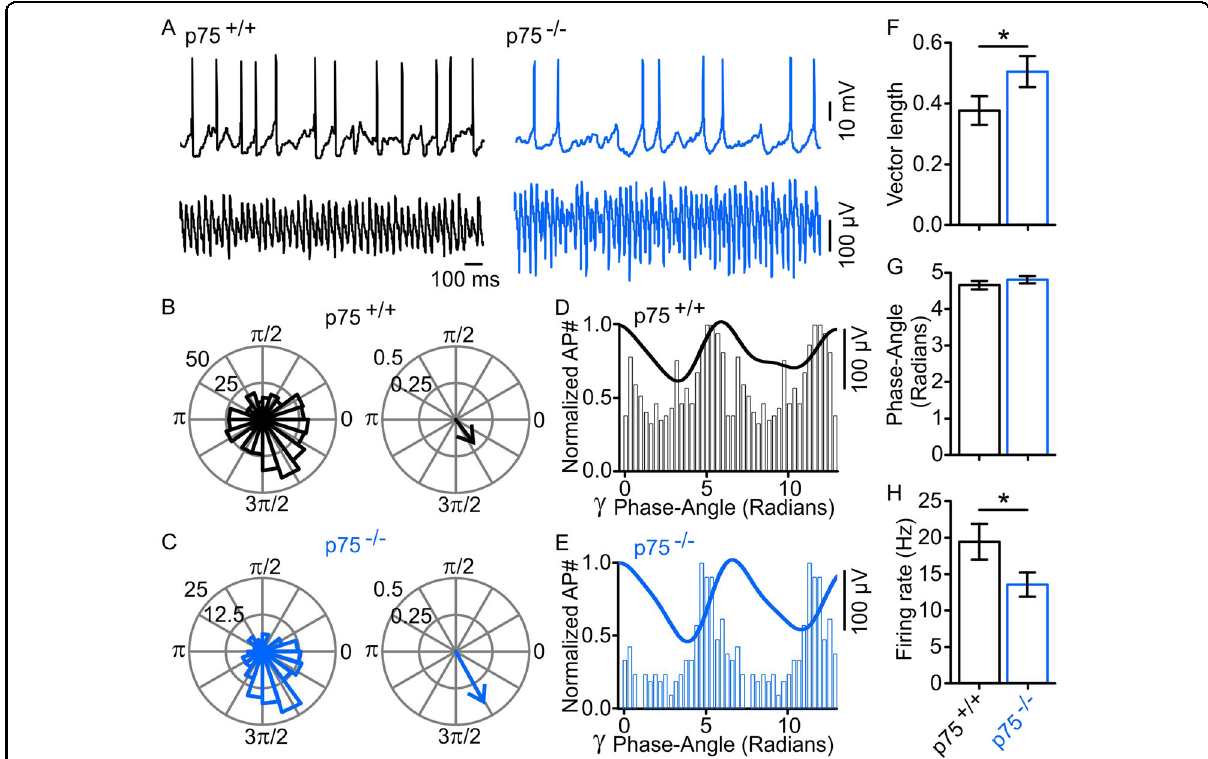
Fig. 3 AP fi ring window of fast-spiking interneurons in p75 + / + and p75 − / − mice. A Representative traces of AP fi ring from fast-spiking interneurons were recorded concomitantly with gamma oscillations ( γ ) in area CA3 20 min after 20 µM CCh. B Polar plots showing the distribution of APs within the γ cycle in p75 + / + mice. Note that a narrower fi ring distribution resulting in a larger vector in p75 − / − mice ( C ) denotes a higher fi ring synchronization compared to the fi ring behavior of FSNs in p75 + / + mice. D Normalized AP distribution of two γ cycles showing fi ring coincidence with a representative sample trace from p75 + / + and p75 − / − ( E ) recordings, also showing a tightened fi ring window in p75 − / − strain (better AP synchronization). F Resultant vector length quanti fi cation (p75 + / + : 0.38 ± 0.05, n = 32; p75 − / − : 0.51 ± 0.05, n = 29, p = 0.0240). G No signi fi cant differences were found in the preferred phase angle between both mouse strains (p75 + / + : 4.7 ± 0.1 radians, n = 32; p75 − / − : 4.8 ± 0.1 radians, n = 29, p = 0.3505). H Firing rate quanti fi cation (p75 + / + : 19.4 ± 2.5 Hz, n = 32; p75 − / − : 13.5 ± 1.7 Hz, p = 0.0281). Data are presented as mean ± SEM. * p < 0.05 compared to p75 + / +